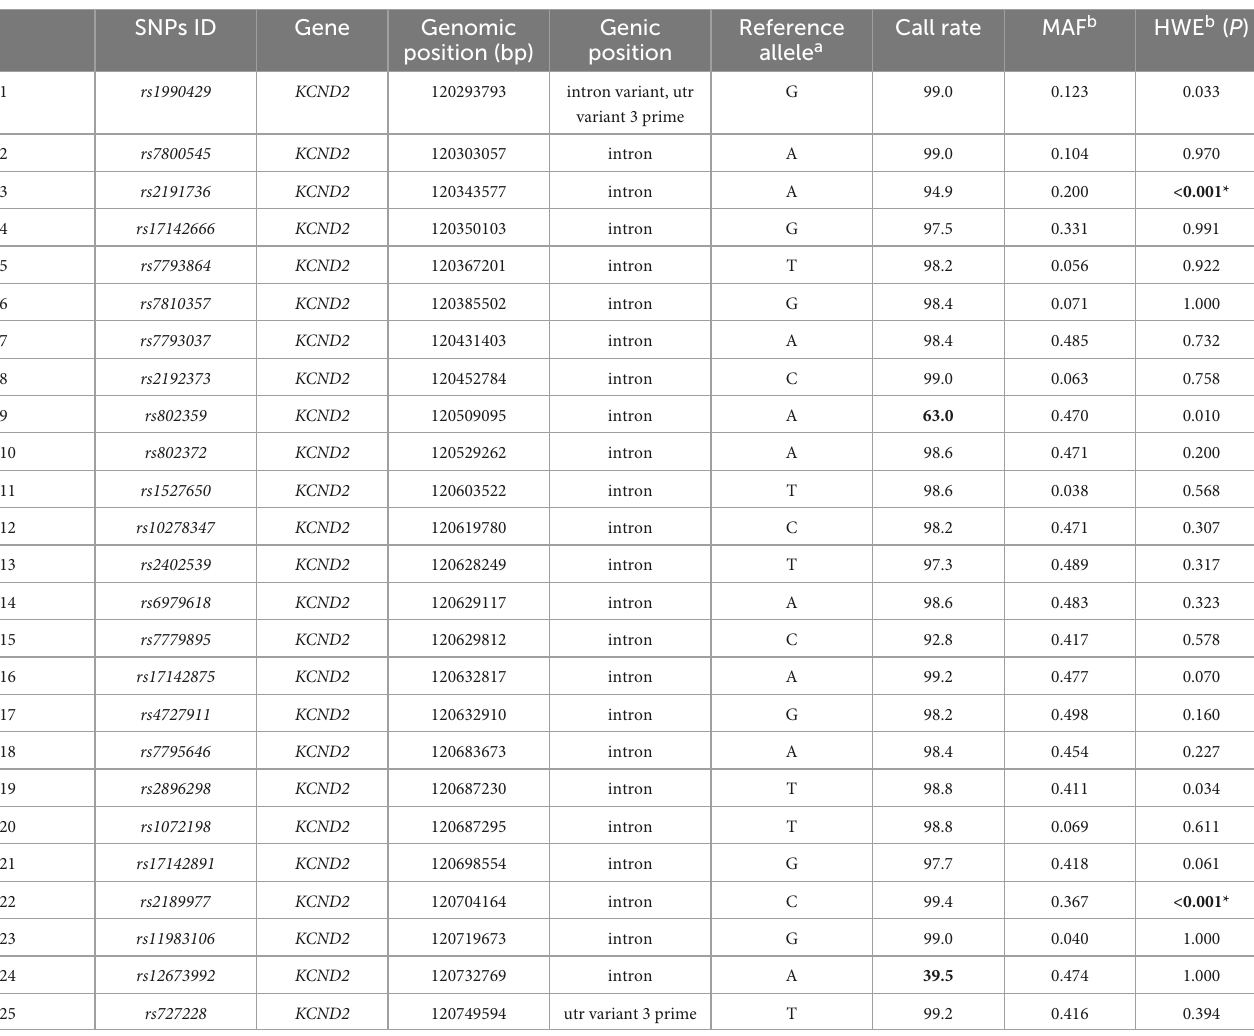
TABLE 2 Characteristics of KCND2 single nucleotide polymorphisms